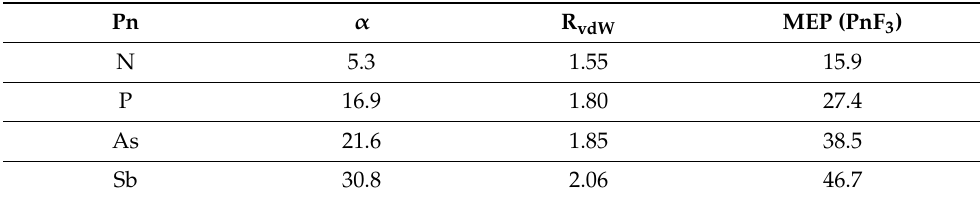
Table 3. Atomic polarizabilities ( α , a.u.) of pnictogen (Pn) elements, van der Waals radii (in Å), and